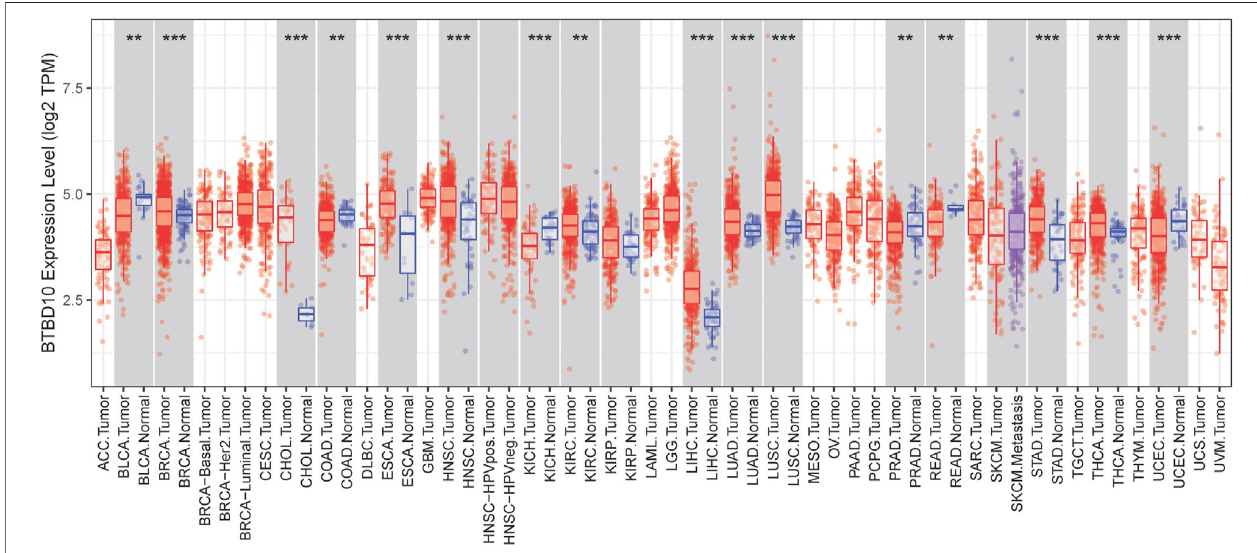
FIGURE 1 | BTBD10 expression levels in various cancer tissues determined using the TIMER analysis. p < 0.001 (cid:1) ***, p < 0.01 (cid:1) **, and p < 0.05 (cid:1)